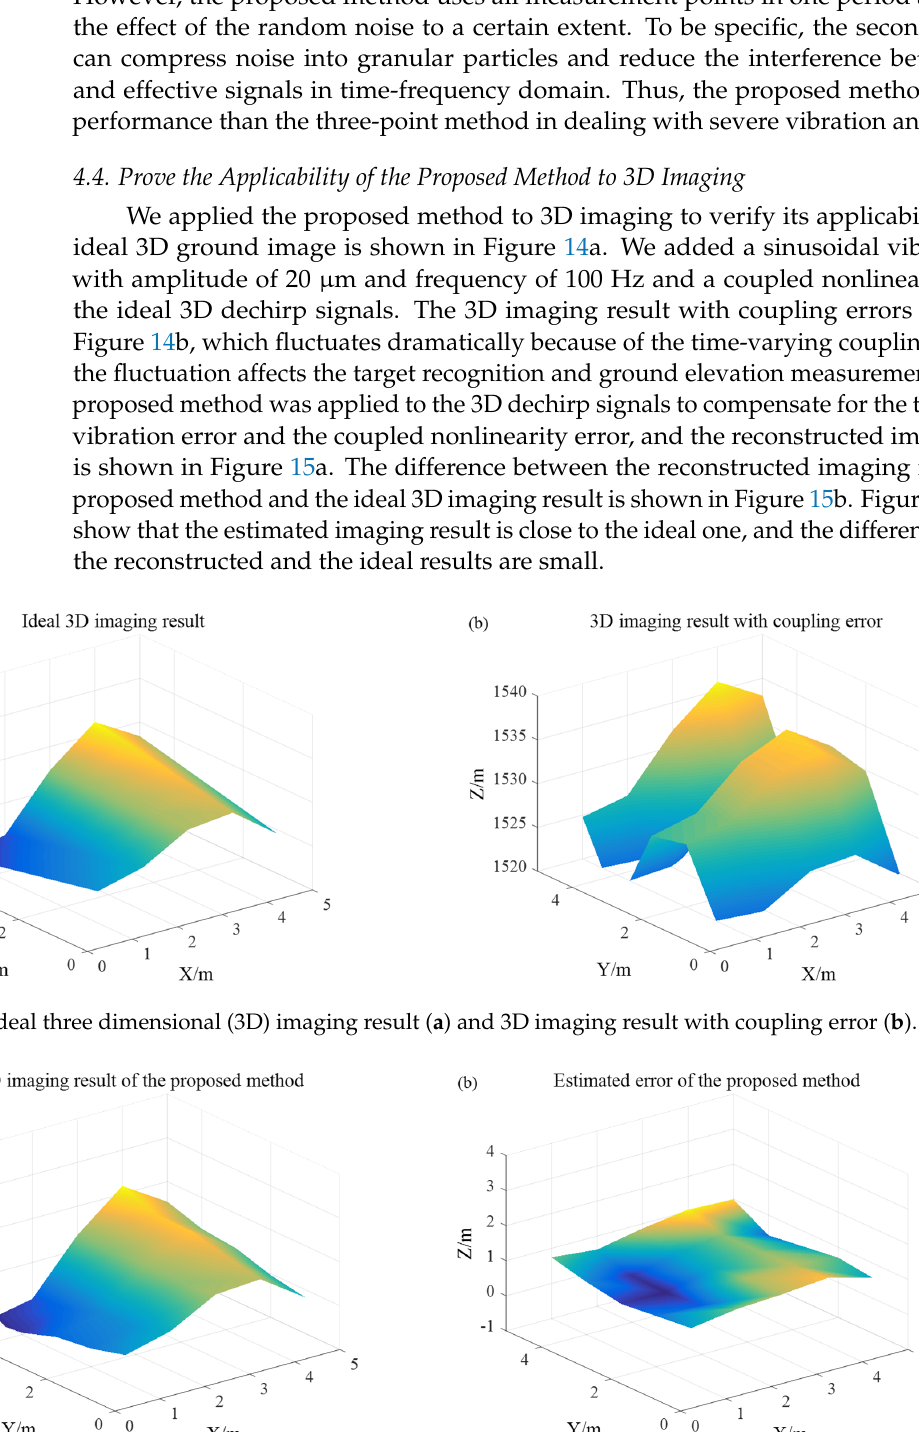
Figure 15. ( a ) Reconstructed 3D imaging result using the proposed method; ( b ) the differences between the reconstructed and the ideal 3D imaging results.